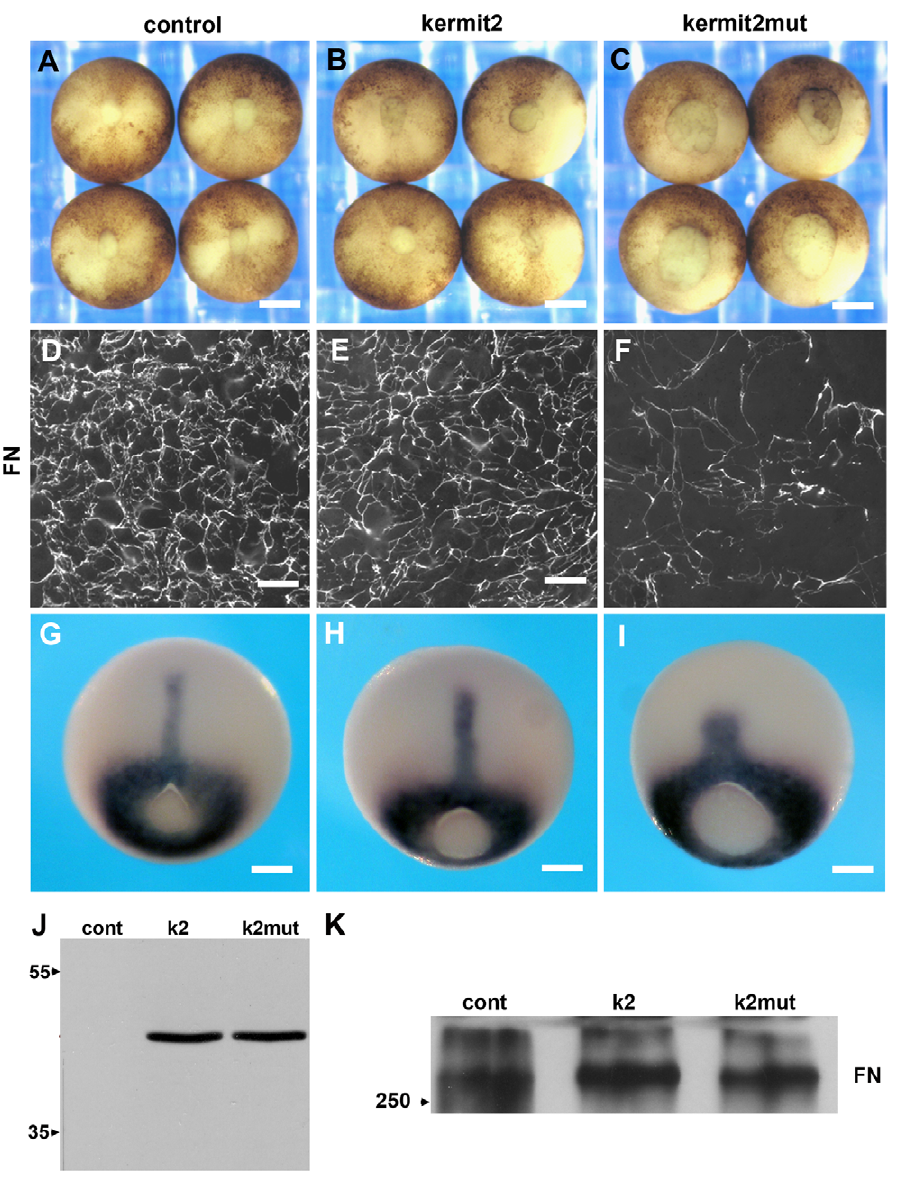
Figure 2. Kermit2 mut inhibits Xenopus gastrulation. (A) Control embryos injected with water close their blastopores and (D) assemble a dense FN matrix. (B) Embryos injected with kermit2 also gastrulate and (E) assemble FN matrix normally. (C) Embryos injected with kermit2mut mRNA fail to close the blastopore and (F) have a sparse FN matrix. (G–I) Xbra in situ hybridizations indicate normal mesodermal patterning in (G) control embryos, as well as (H) embryos expressing kermit2, and in embryos expressing (I) kermit2mut. Note that axial extension is inhibited in (I). (J) Western blot demonstrating equal expression of HA tagged kermit2 and kermit2 constructs. Embryos injected with water (cont) do not express the construct, while embryos injected with RNA encoding kermit2 (k2) and kermit2mut (k2mut) express equal amounts of either construct. Molecular mass markers are indicated on the right of the panel. (K) Kermit2mut expression does not inhibit FN protein accumulation. Western blots demonstrate that there is no substantial change in FN protein expression (FN) in water injected embryos (cont), embryos expressing kermit2 (k2), or embryos expressing kermit2mut (k2mut). Molecular mass markers are indicated on the right of the panel. (A–C) size marker =200 m M. (D–F) size marker =30 m M. (G–I) size marker 100 m